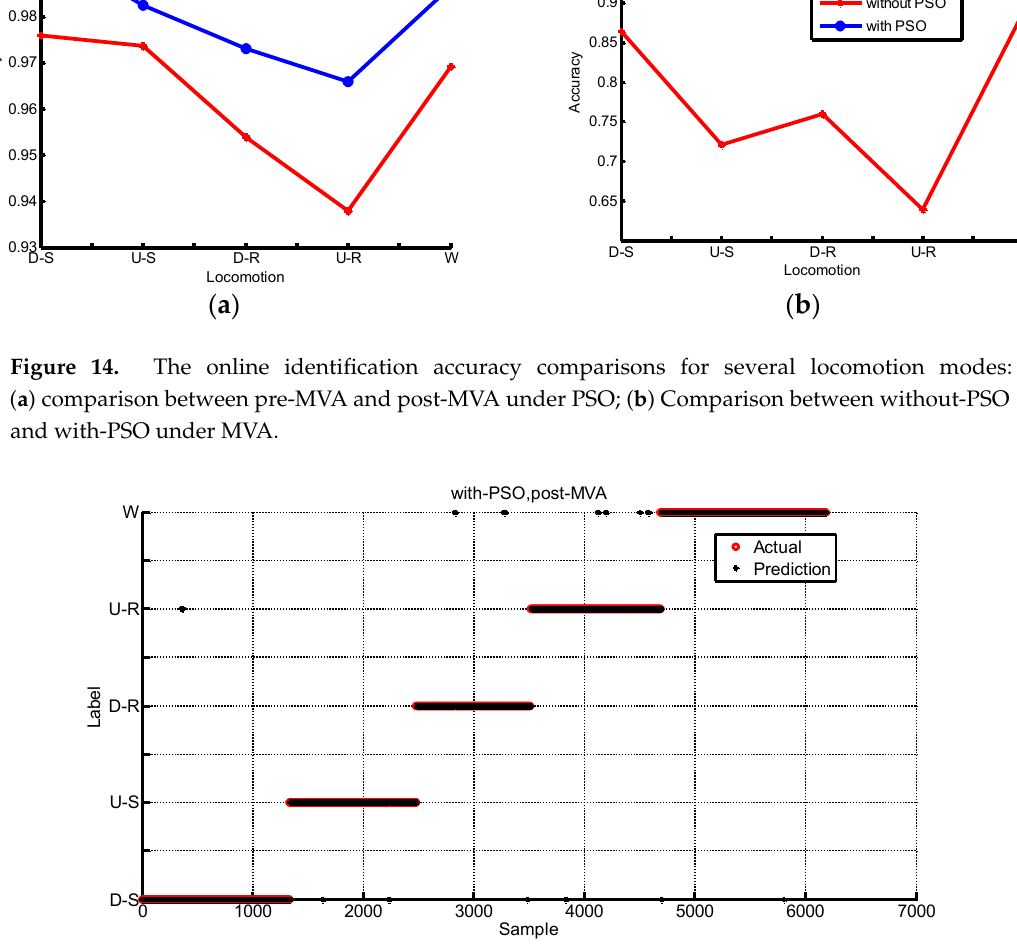
Figure 15. The classification result using PSO-SVM with MVA. Those five instances along the sample